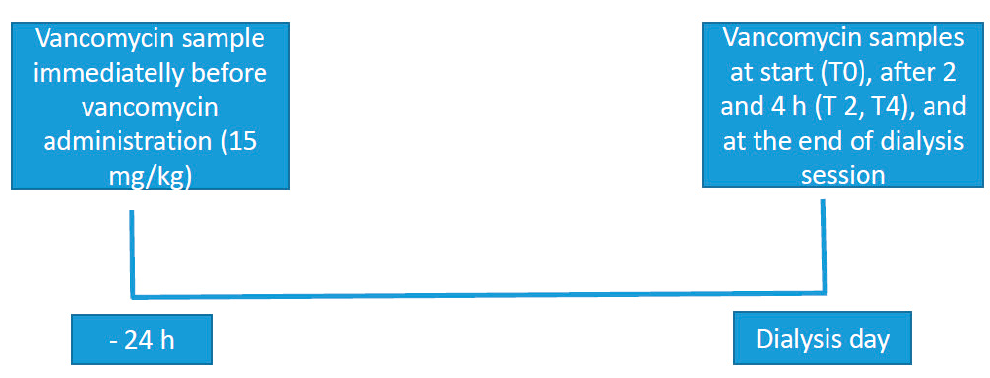
Figure 1. Dialysis procedure, administration of vancomycin and sampling.